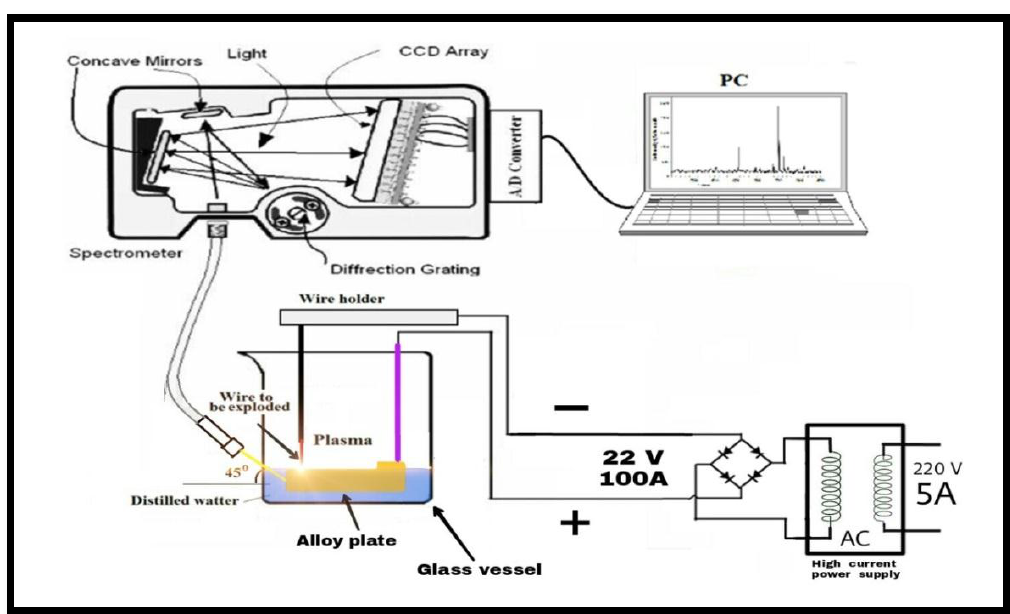
Fig. 1: Schematic diagram for alloys nanoparticles preparations and optical emission